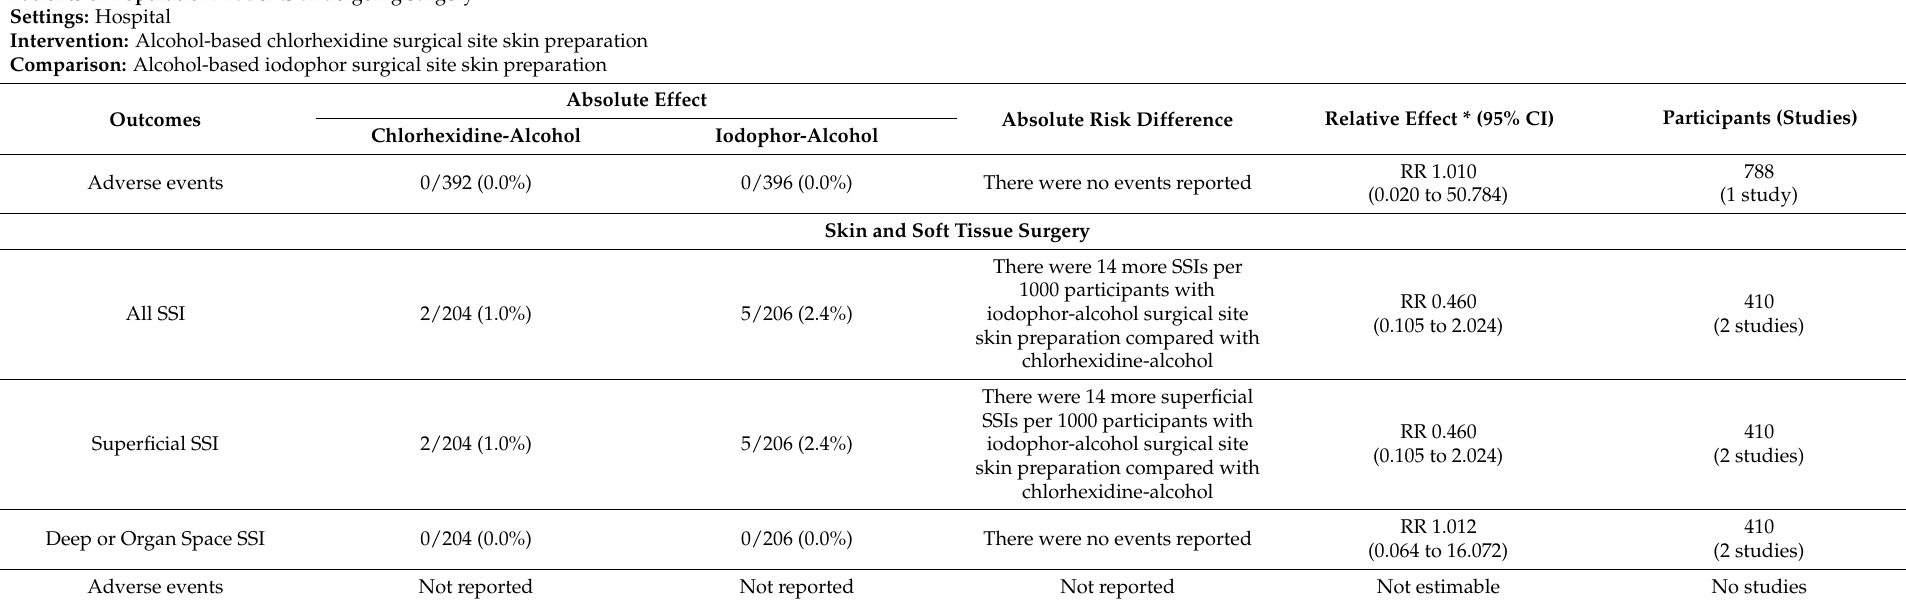
Patients or Population: Patients undergoing surgery Settings: Hospital Intervention: Alcohol-based chlorhexidine surgical site skin preparation Comparison: Alcohol-based iodophor surgical site skin